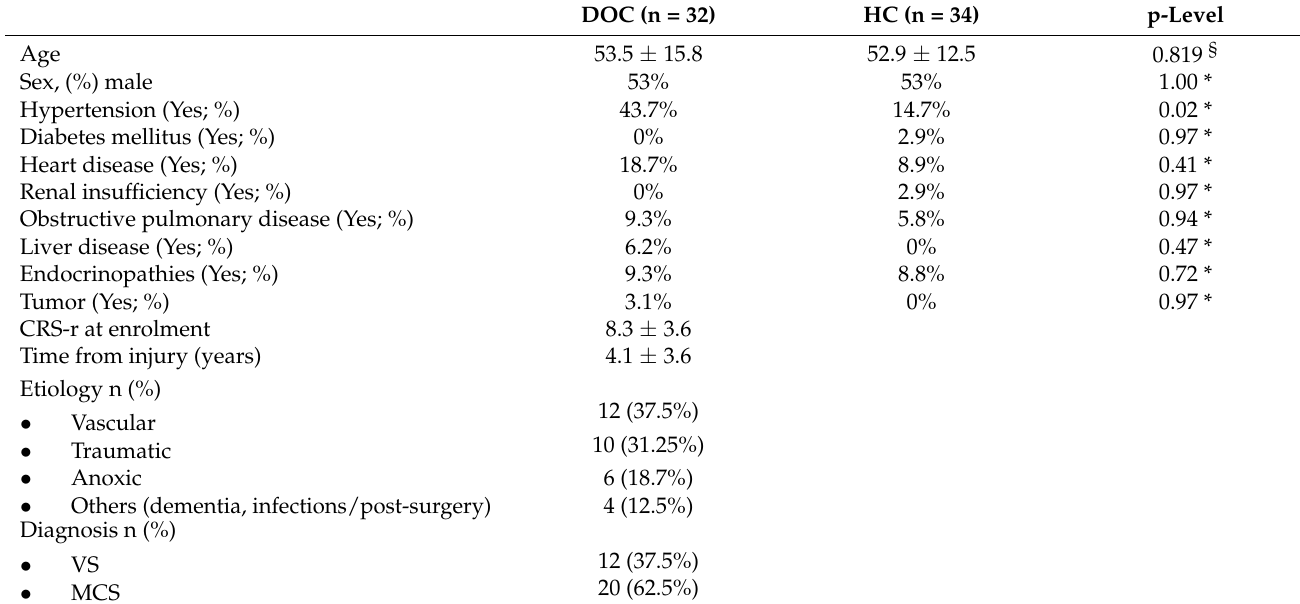
Table 1. Demographic and clinical characteristics of enrolled DOC patients and